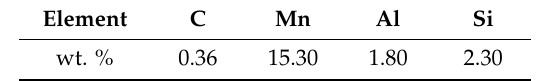
Table 1. Chemical composition of HSD ® 600 steel in wt. %.